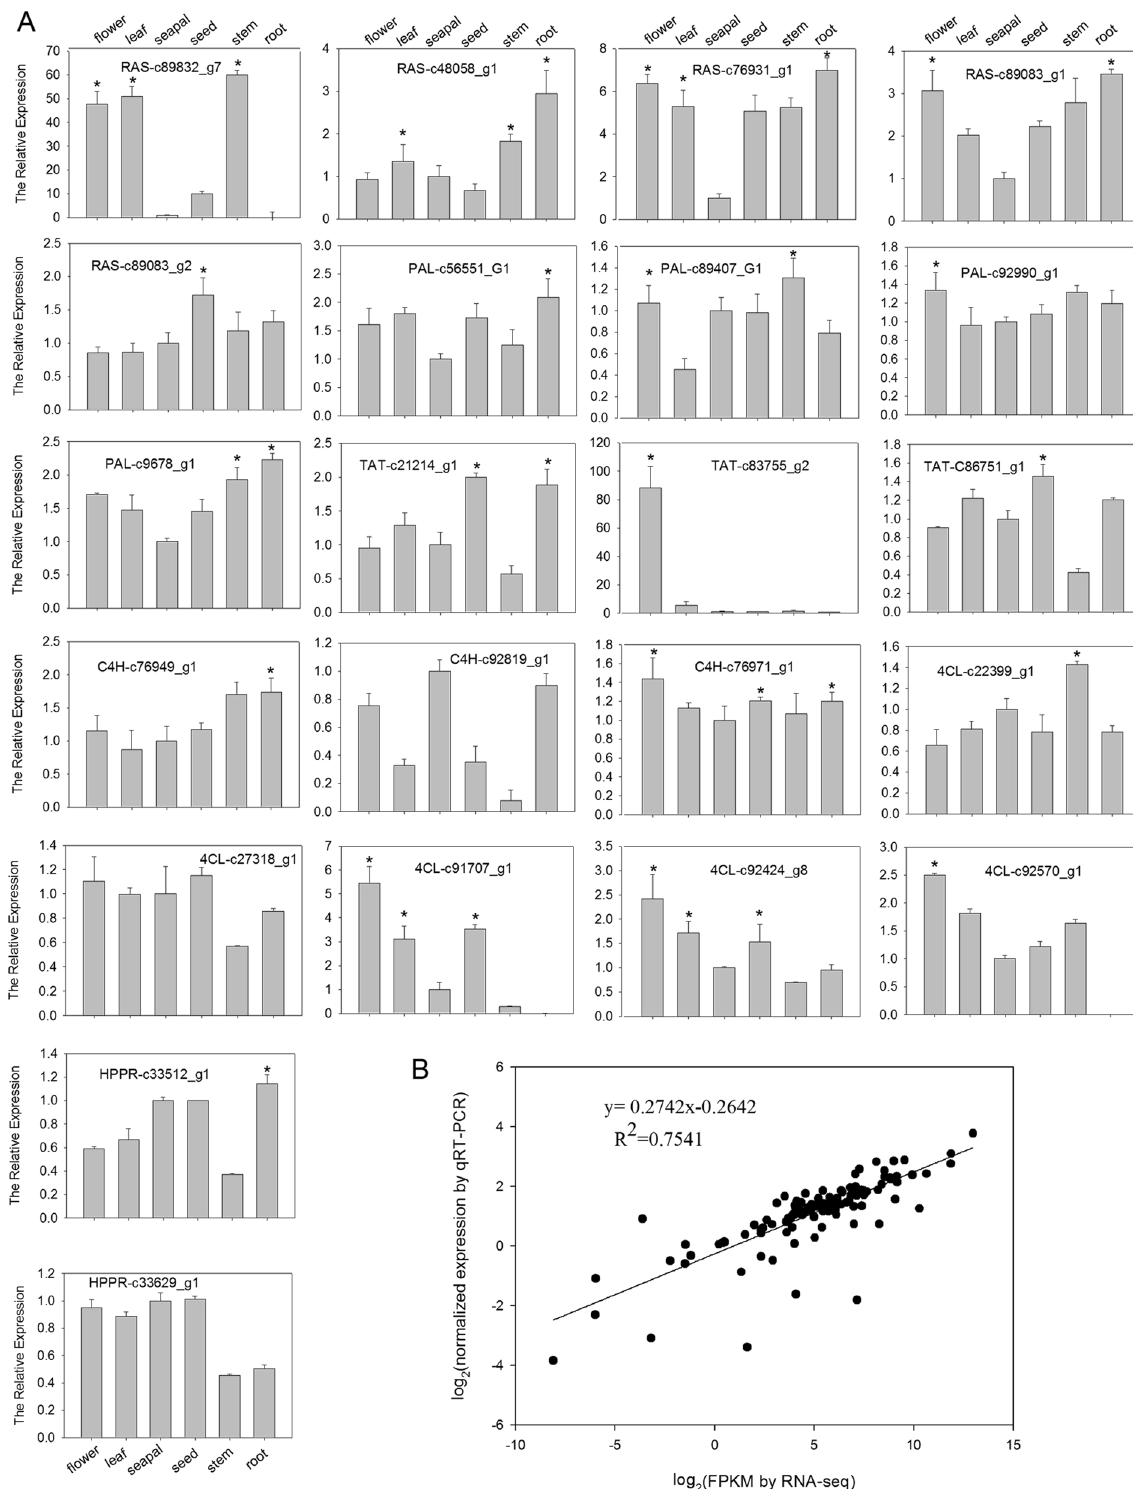
Figure 6. qRT-PCR validation of the expression of the predicted biosynthetic genes related to RA in the six organs by RNA-seq. ( A ) Expression of the genes determined by qRT-PCR. Both DtACT and DtEF1 were selected as the internal controls to normalize the expression. Expression levels of genes in sepals were arbitrarily set to 1 and the other organs were given relative to this. Three biological replicates were performed. A significance threshold of P < 0.05 was considered statistically significant. ( B ) Correlation of the expression results obtained from qRT-PCR and RNA-seq for biosynthetic genes related to